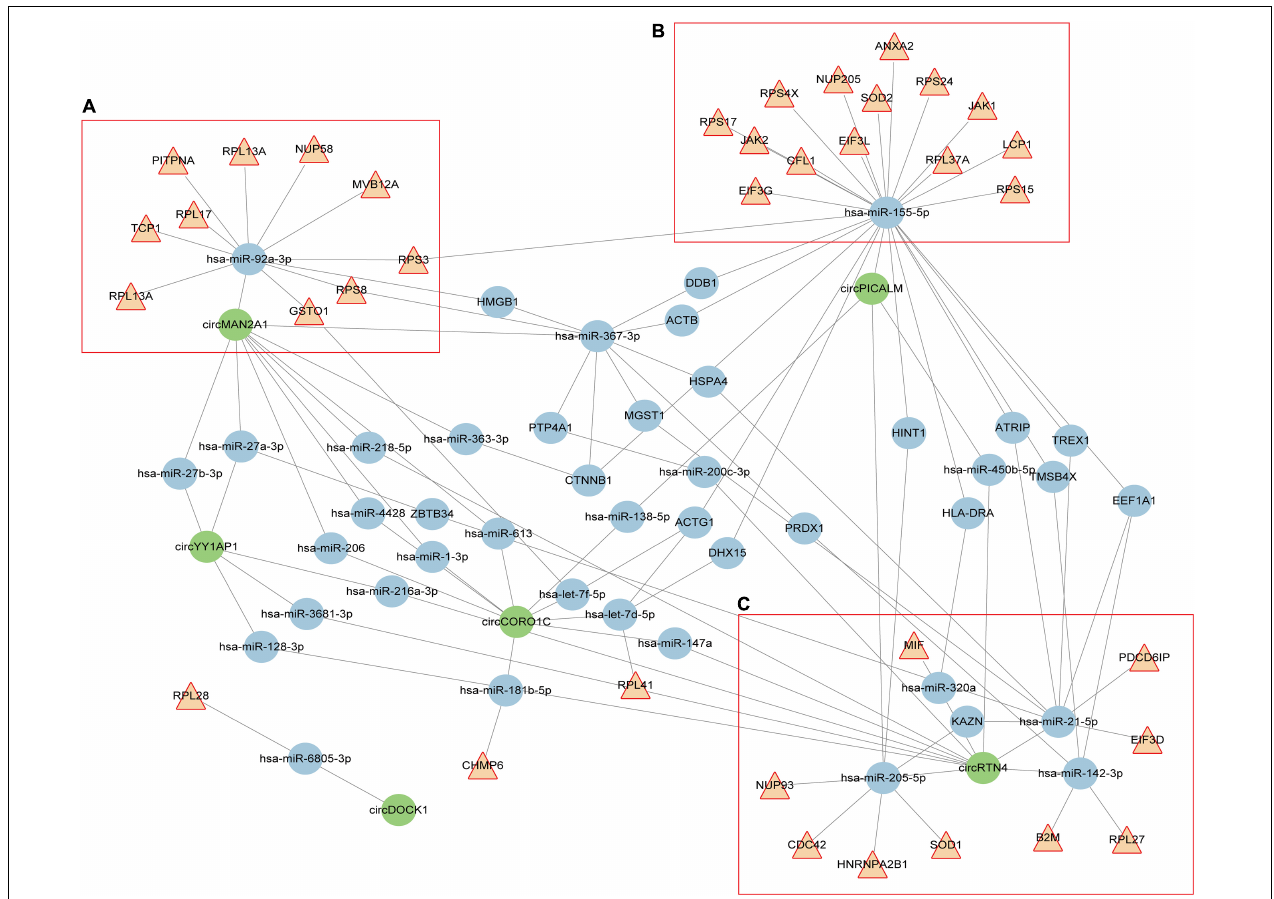
FIGURE 2 | circRNA-miRNA-mRNA interaction network constructed from shared aberrant circRNAs in AD and cancers. Brown triangular nodes represent genes annotated in IL-12 signaling pathways or viral response. circRNAs are colored in green. Edges represent the interactions derived from CLIP data. (A–C) Three key clusters that included three highly expressed circRNAs (circPICALM, circMAN2A1, and